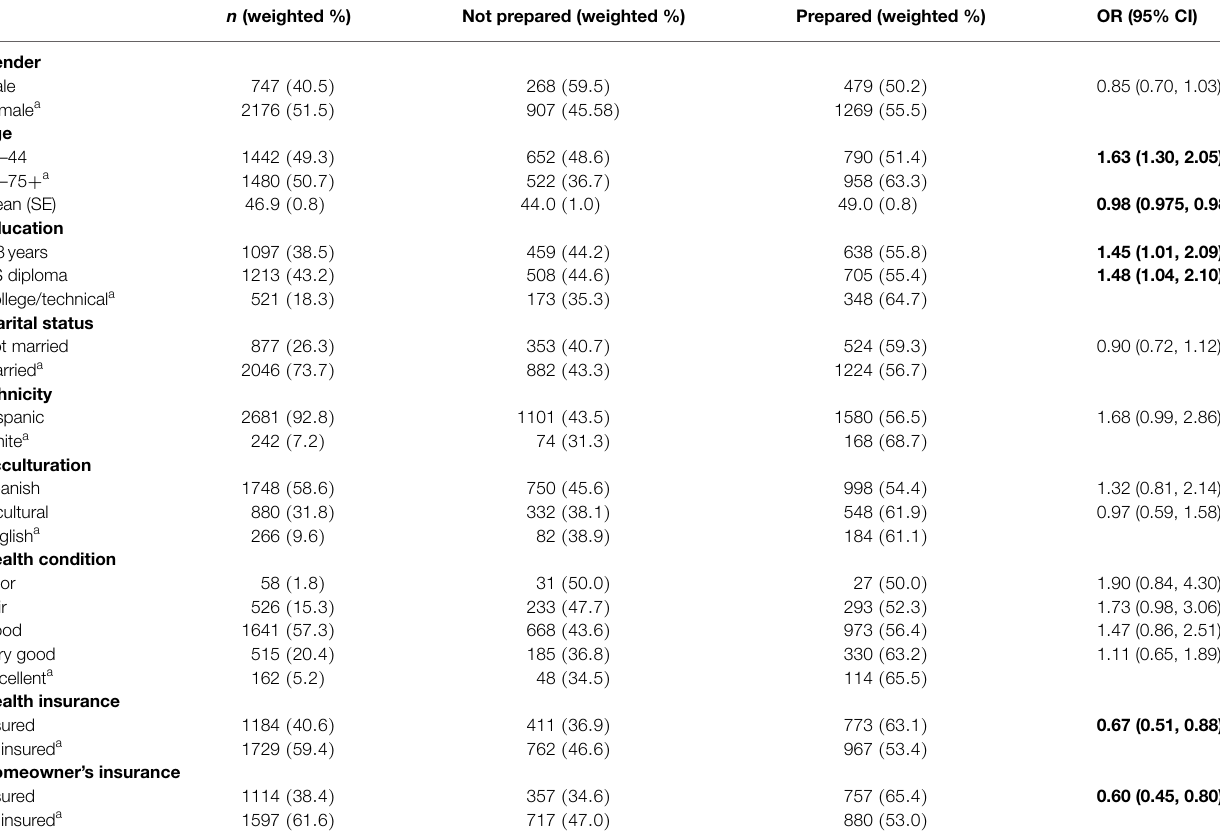
TABLE 3 | Individual level characteristics by hurricane preparedness . n (weighted